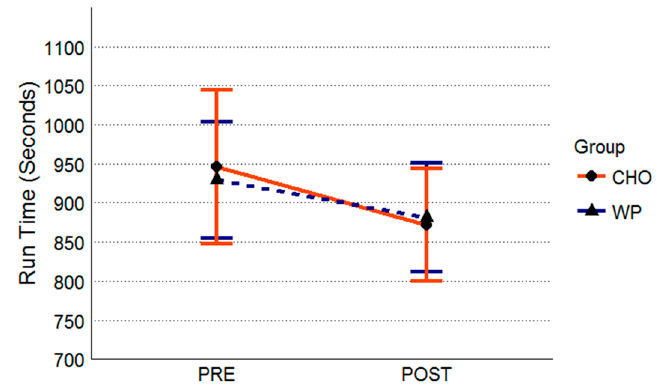
Figure 4. Run Performance. All data are presented as means ± standard deviation values.